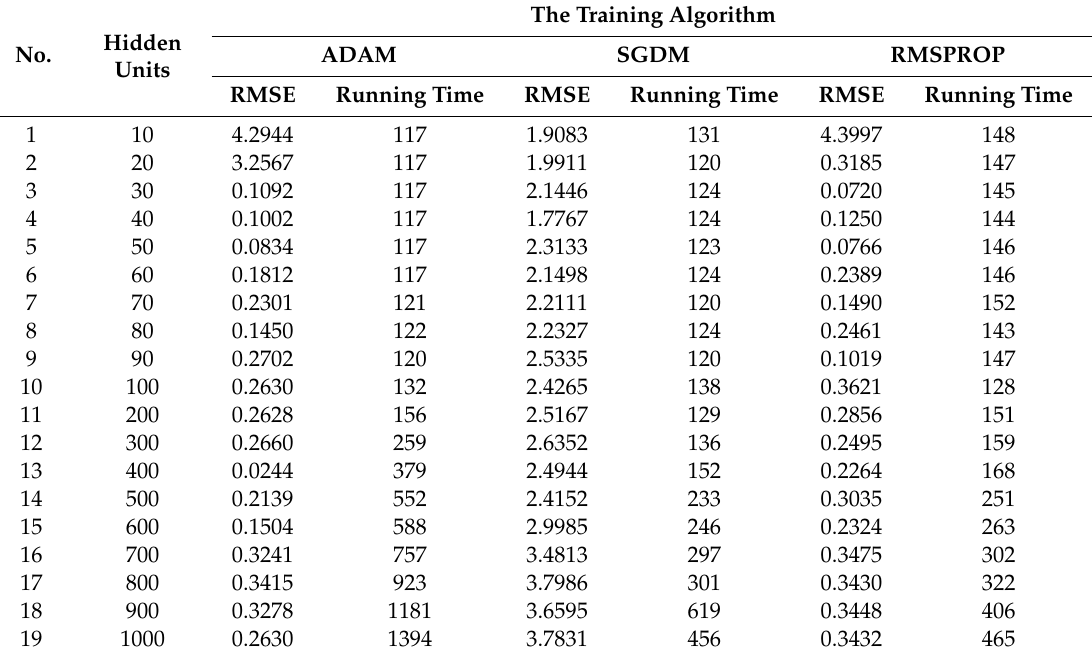
Table 2. The synthesis of the experimental results registered for the 19 developed long short-term memory (LSTM) ANNs per each training